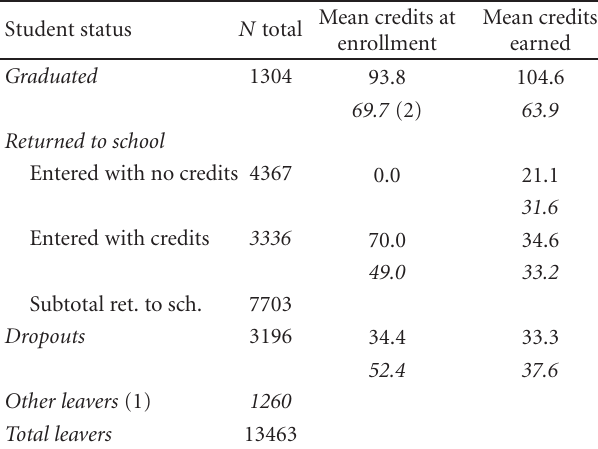
Table 2: Students who left OFY/OFL Charter Schools in 2006-2007, by destination and number of high school credits earned while enrolled in